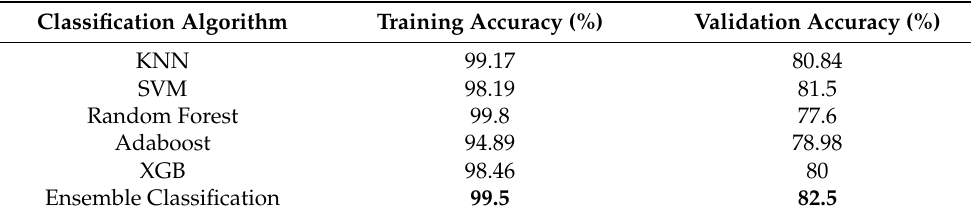
Table 3. Training and validation accuracies of different classification algorithms on training of patch features. Bold font values indicate highest values.